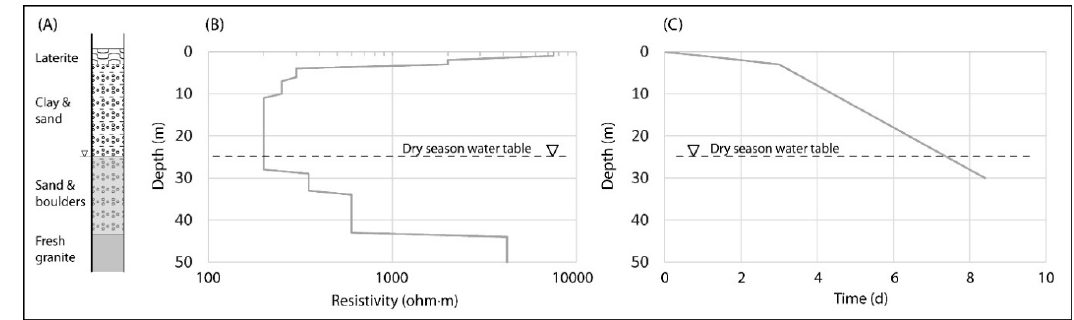
Figure 10. ( A ) Geological section; ( B ) resistivity curve obtained by vertical electrical sounding; ( C ) drilling time in days.